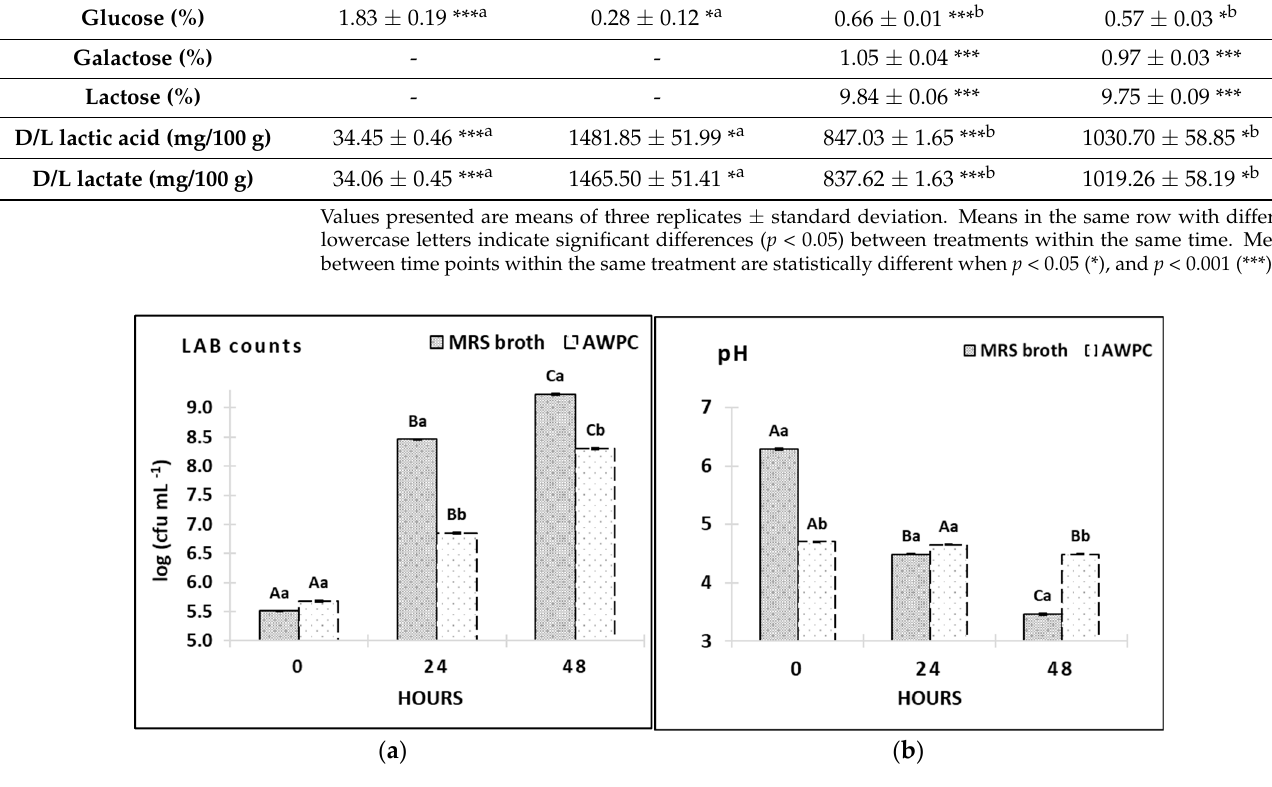
Figure 4. LAB counts ( a ) and pH ( b ) in MRS broth and AWPC L. paracasei A11 fermentates (AWPC) kept in a culture flask for 48 h at 37 °C. Means among storage days within the same cheese treatment marked with different upper-case letters are significantly different ( p ≤ 0.05). Means between cheese treatments within the same storage day marked with different lower-case letters are significantly different ( p ≤ 0.05).